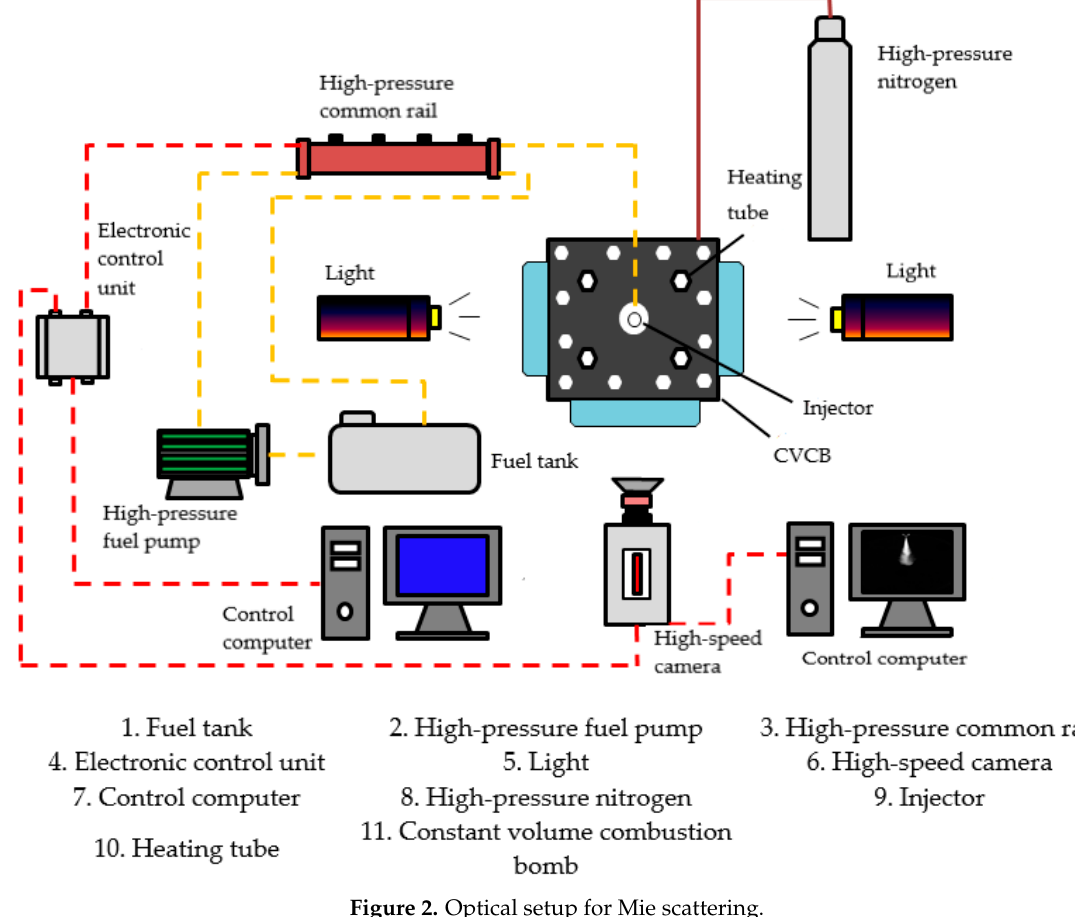
Figure 2. Optical setup for Mie scattering.